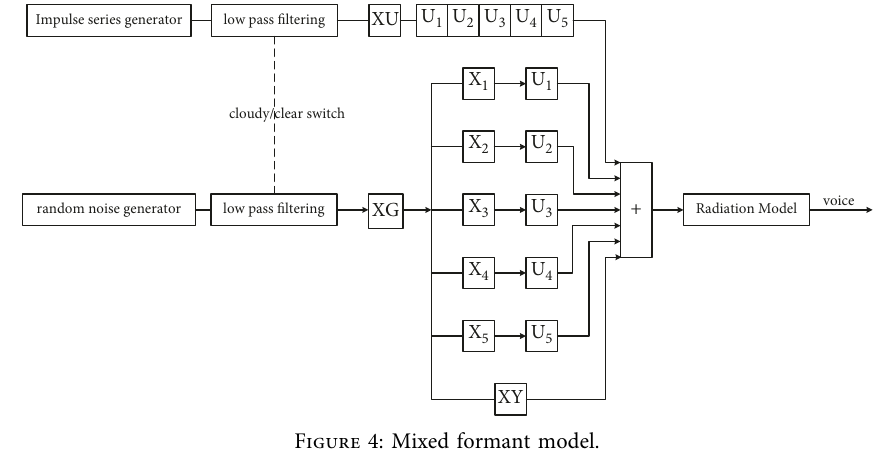
Figure 4: Mixed formant